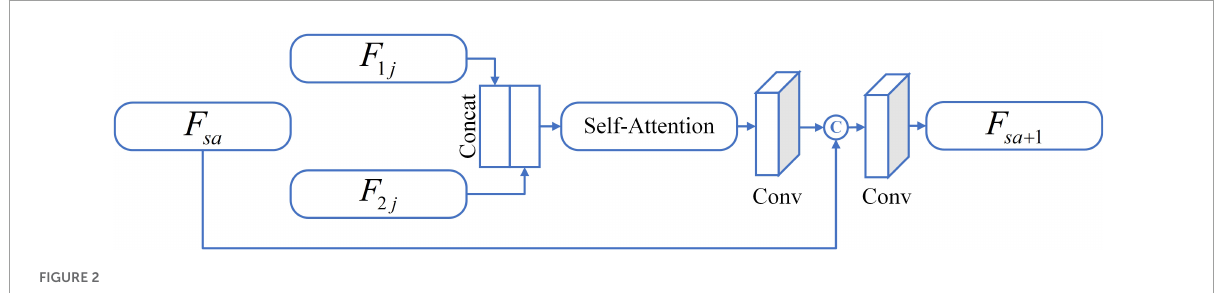
FIGURE2 The diagrammatic sketch of